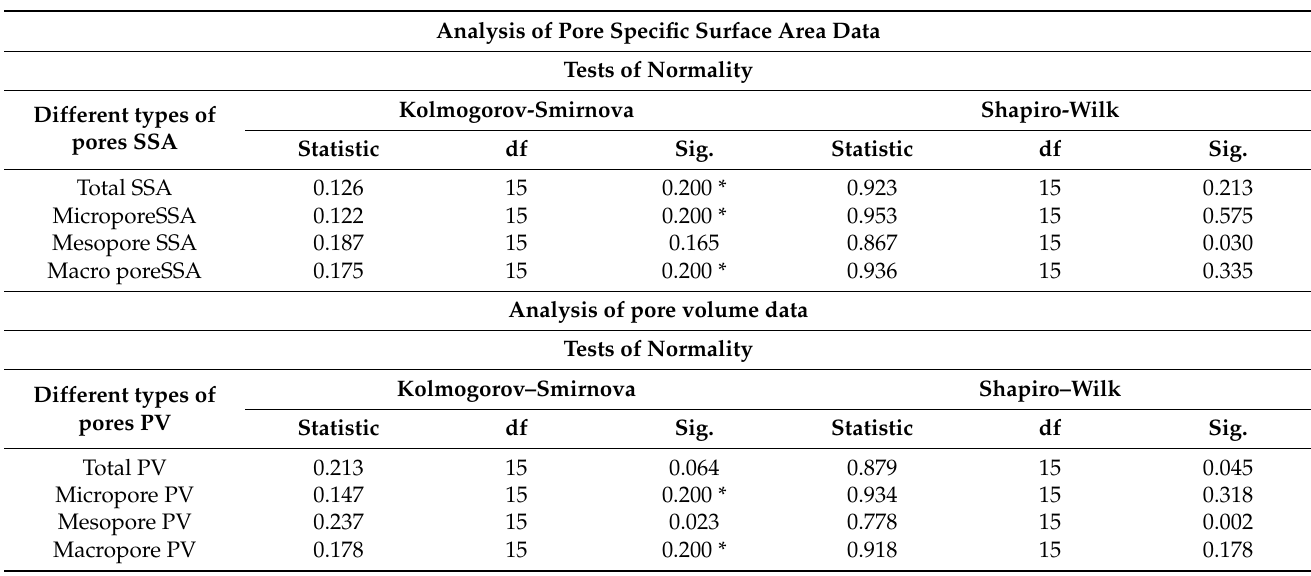
Table A2. Pore structure data